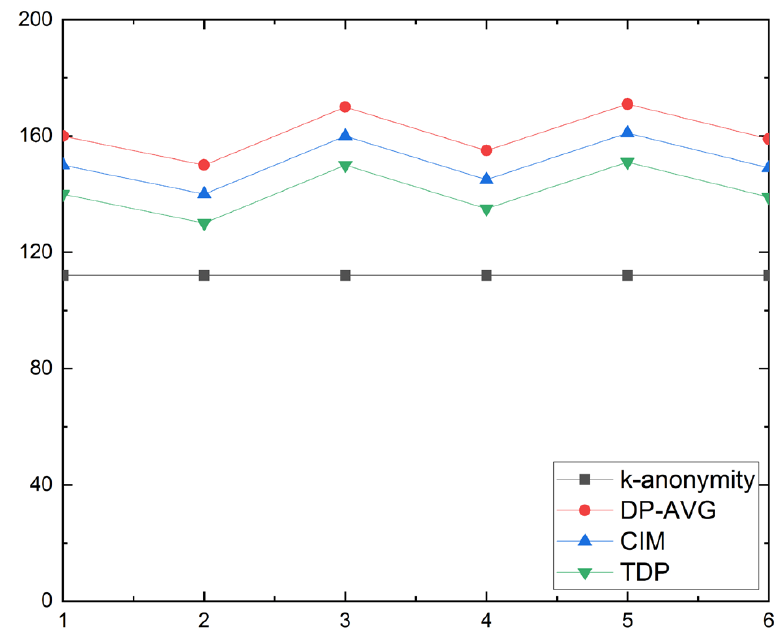
Figure 6. MSE comparison diagram for Geolife Trajectories dataset.